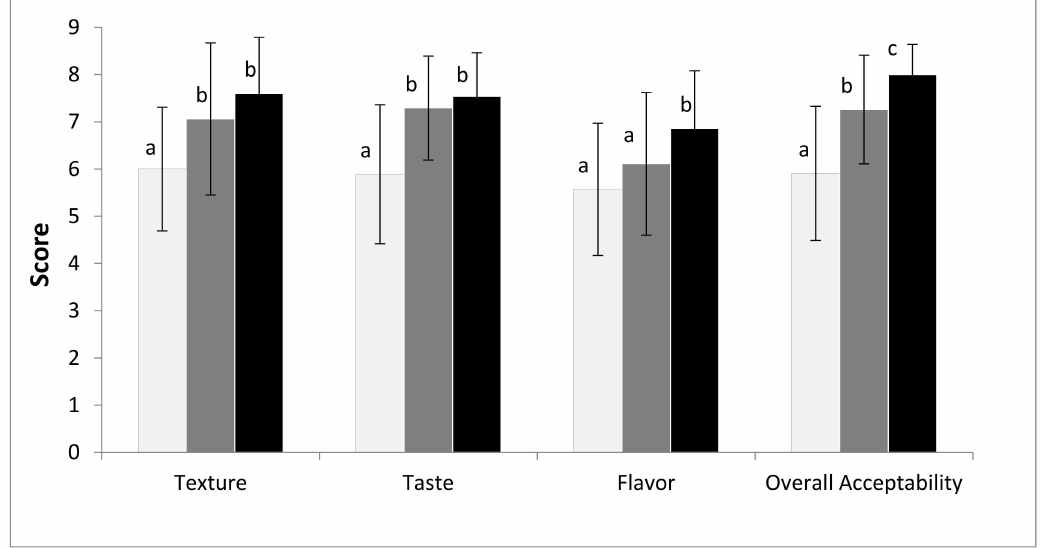
Figure 2. Results of the acceptability sensory test performed on the CP sample (white bars) and on the SP samples, the latter as blind (grey bars) and informed tests (black bars). Di ff erent letters (a, b, c) for the same sensory parameter denote a statistically significant di ff erence between samples at p ≤